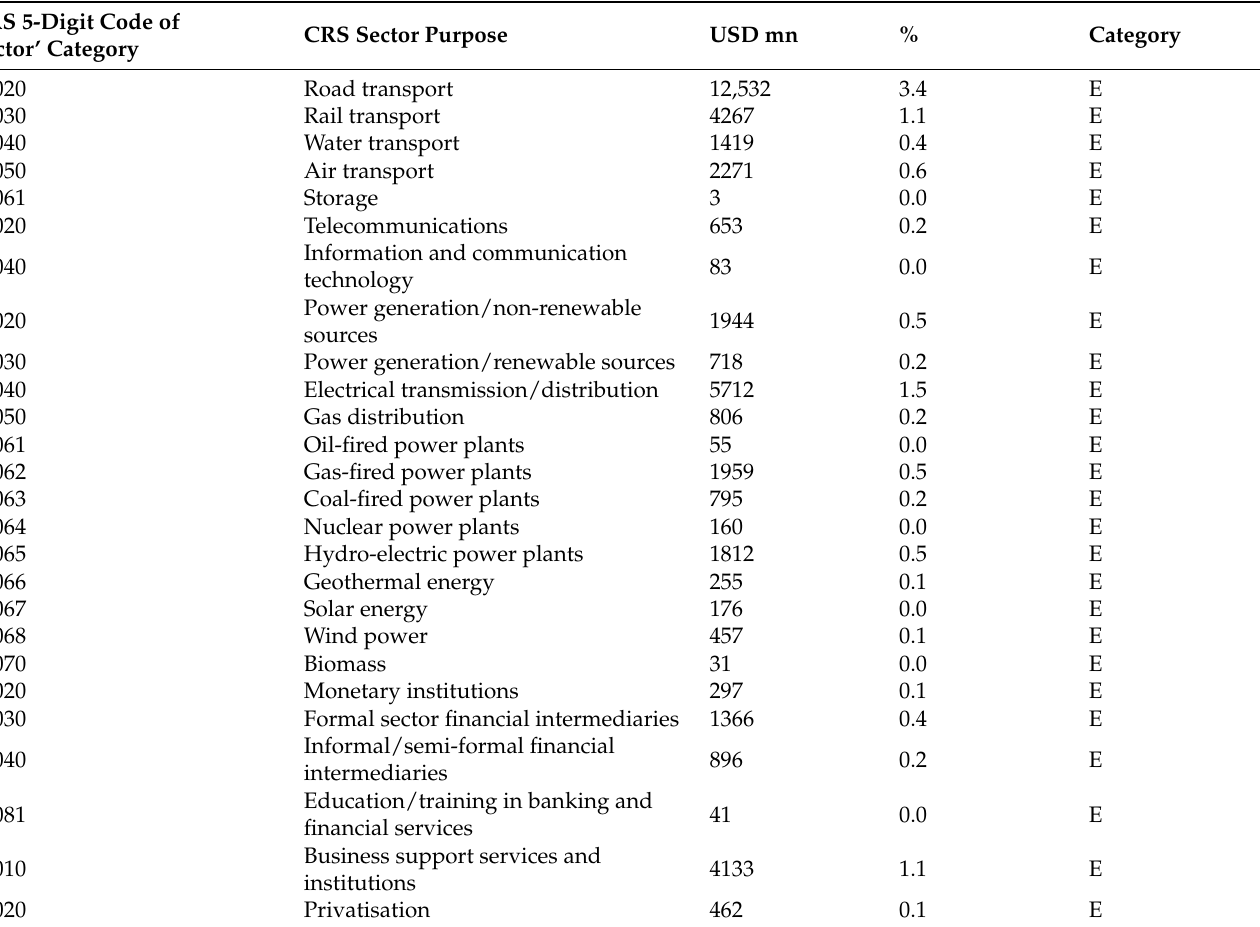
Table A2. List of Clemens’ Classification for the Included Categories of Early-Impact Aids Measure: OECD ODA Commitment Totals by Purpose and Category ,